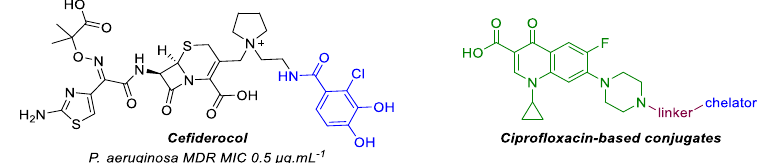
Figure 33. Structures of cefiderocol and ciprofloxacin-based conjugates.